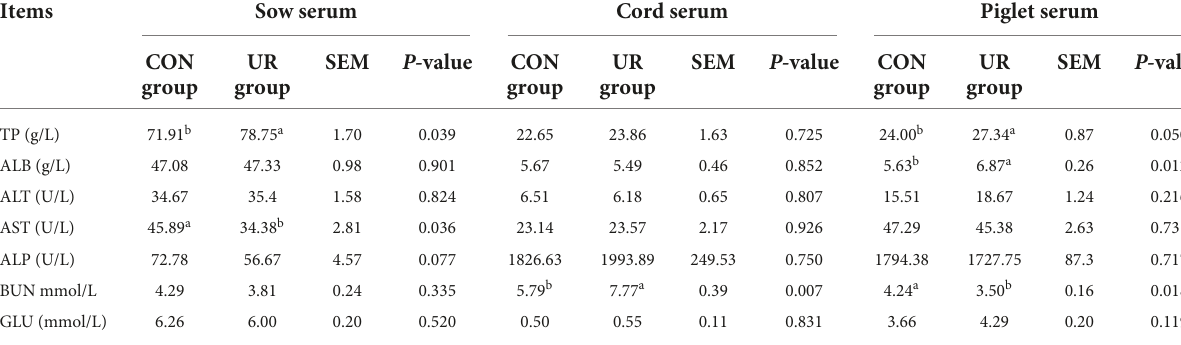
TABLE 3 Effect of UR on serum biochemical parameters in sow serum, cord serum and piglet serum. Items Sow serum